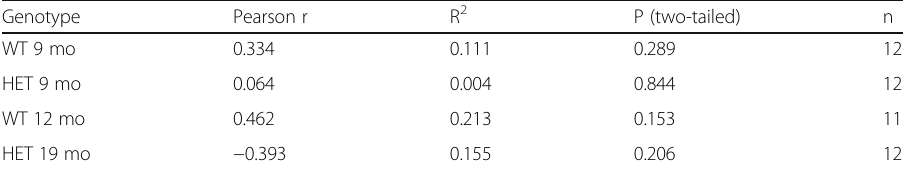
Table 1 Pearson correlation of injected mass of [ 18 F] fallypride and BP ND . No significant correlation was observed Genotype Pearson r R 2 P